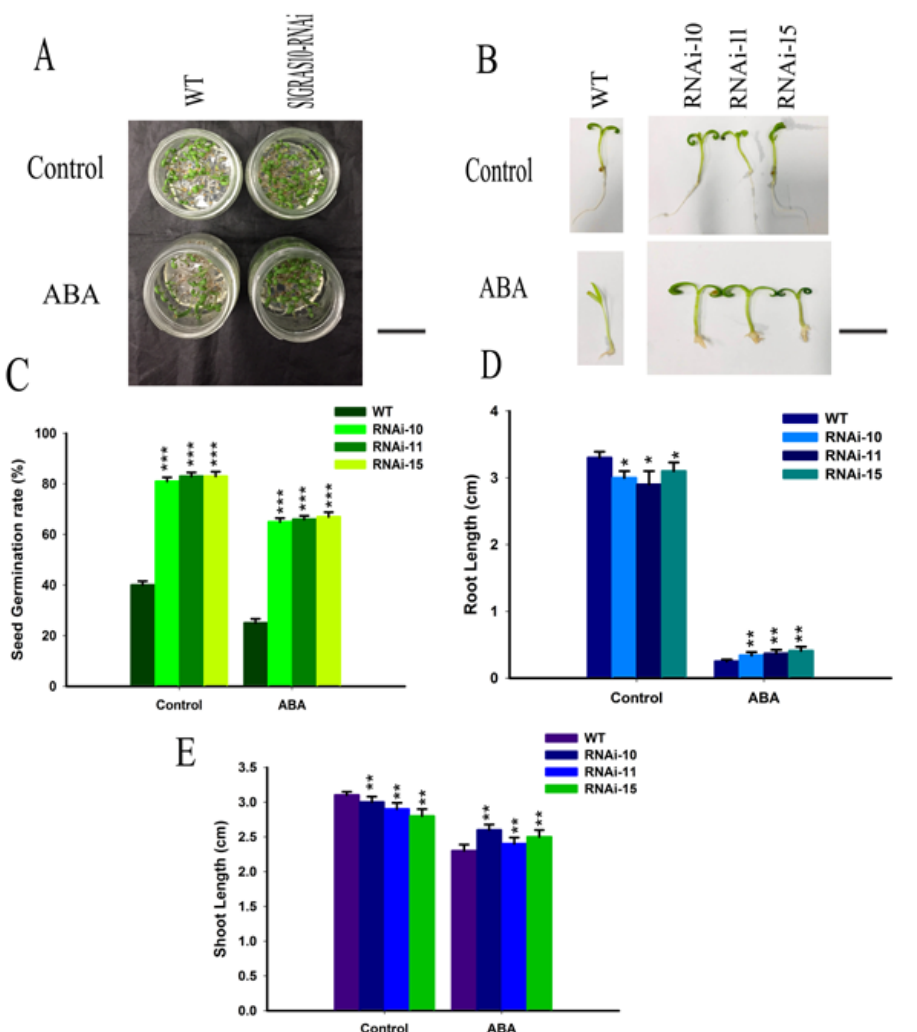
Figure 6. Down-regulation of SlGRAS10 enhances seedling growth to ABA stress. ( A ) The figure shows the growth performance of wild-type and SlGRAS10 -RNAi seedlings under control and ABA stress after 15 days. Scale bar = 5 mm ( B ) Photographs of wild-type and SlGRAS10 -RNAi-10, RNAi-11, and RNAi-15 seedlings under control and salt ABA stress after 15 days. Scale bar = 5 mm. ( C ) The seed Germination rate of SlGRAS10 -RNAi and after control, and ABA treatments ( n = 20). ( D ) Root length of SlGRAS10 -RNAi three lines and wild-type under control, and ABA treatments ( n = 20). ( E ) Shoot lengths of SlGRAS10 -RNAi and wild-type under control, and ABA treatments ( n = 20). The date represents the mean ± SE of three independent replicates. *, **, *** indicates a significant difference ( p < 0.05, p < 0.01, p < 0.001) between transgenic and wild-type plants.